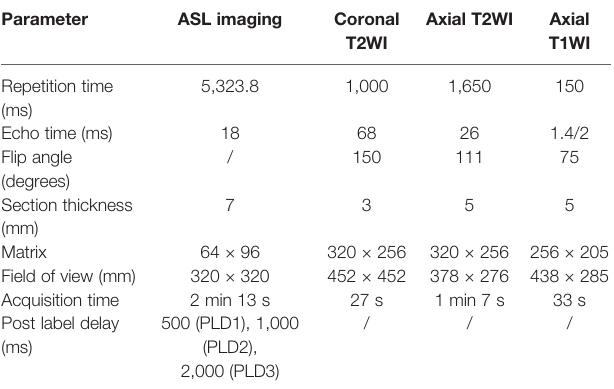
TABLE 1 | Imaging parameters for ASL-MRI, T1WI, T2WI sequences.